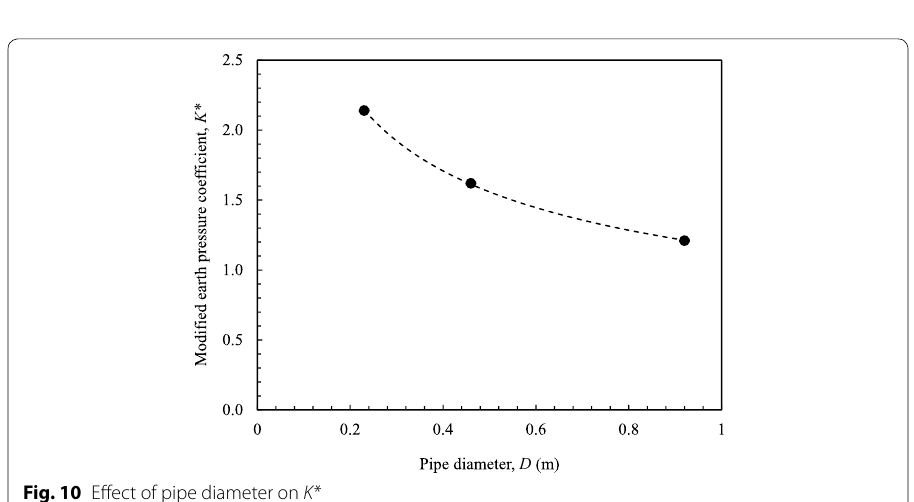
where K* is the modified coefficient of earth pressure, C is constant, K 0 is the coefficient of earth pressure at rest, E is the soil Young’s modulus, γ is the soil unit weight, H is the pipe bur- t ial depth, φ is the soil friction angle, (cid:31) is the shear zone thickness and D is the pipe diameter.